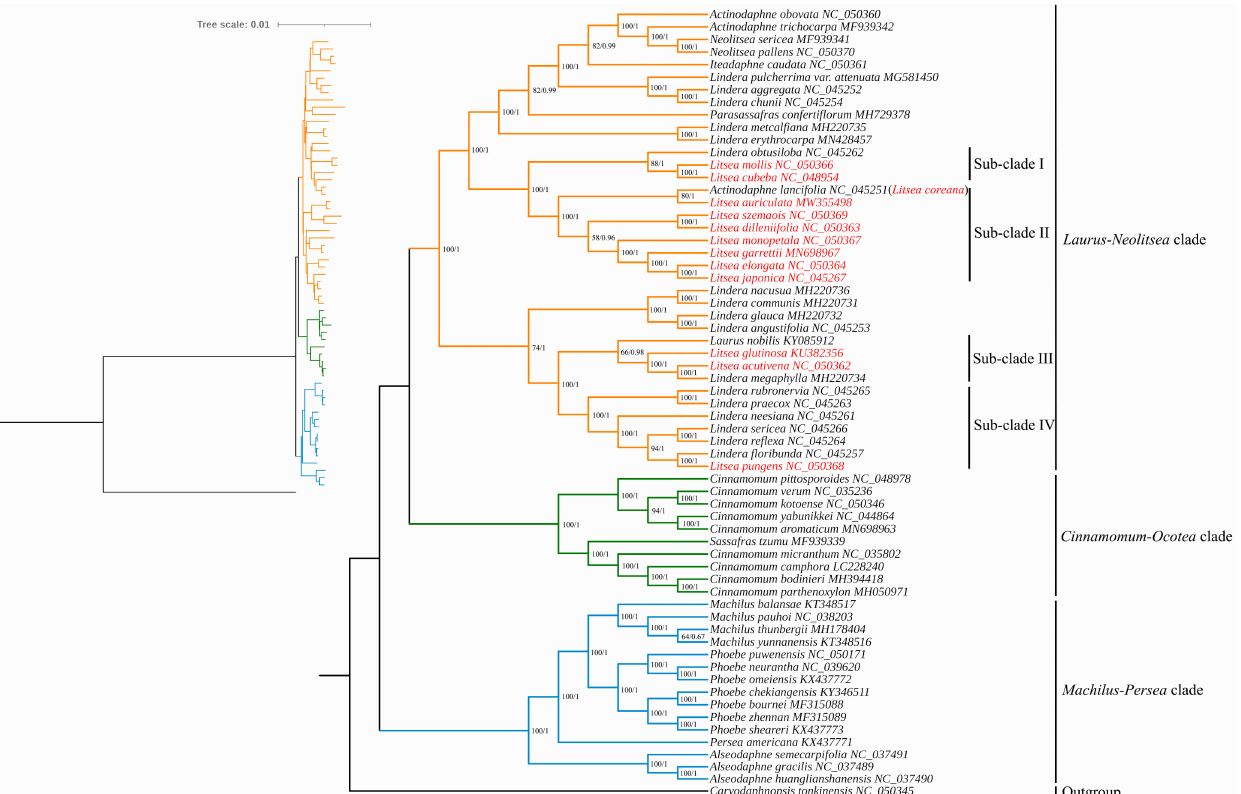
Figure 5. Complete chloroplast genome phylogenetic tree of 63 species inferred from maximum likelihood (ML) and Bayesian inference (BI) analysis. Numbers above the lines represent ML bootstrap values (BS) and BI posterior probabilities